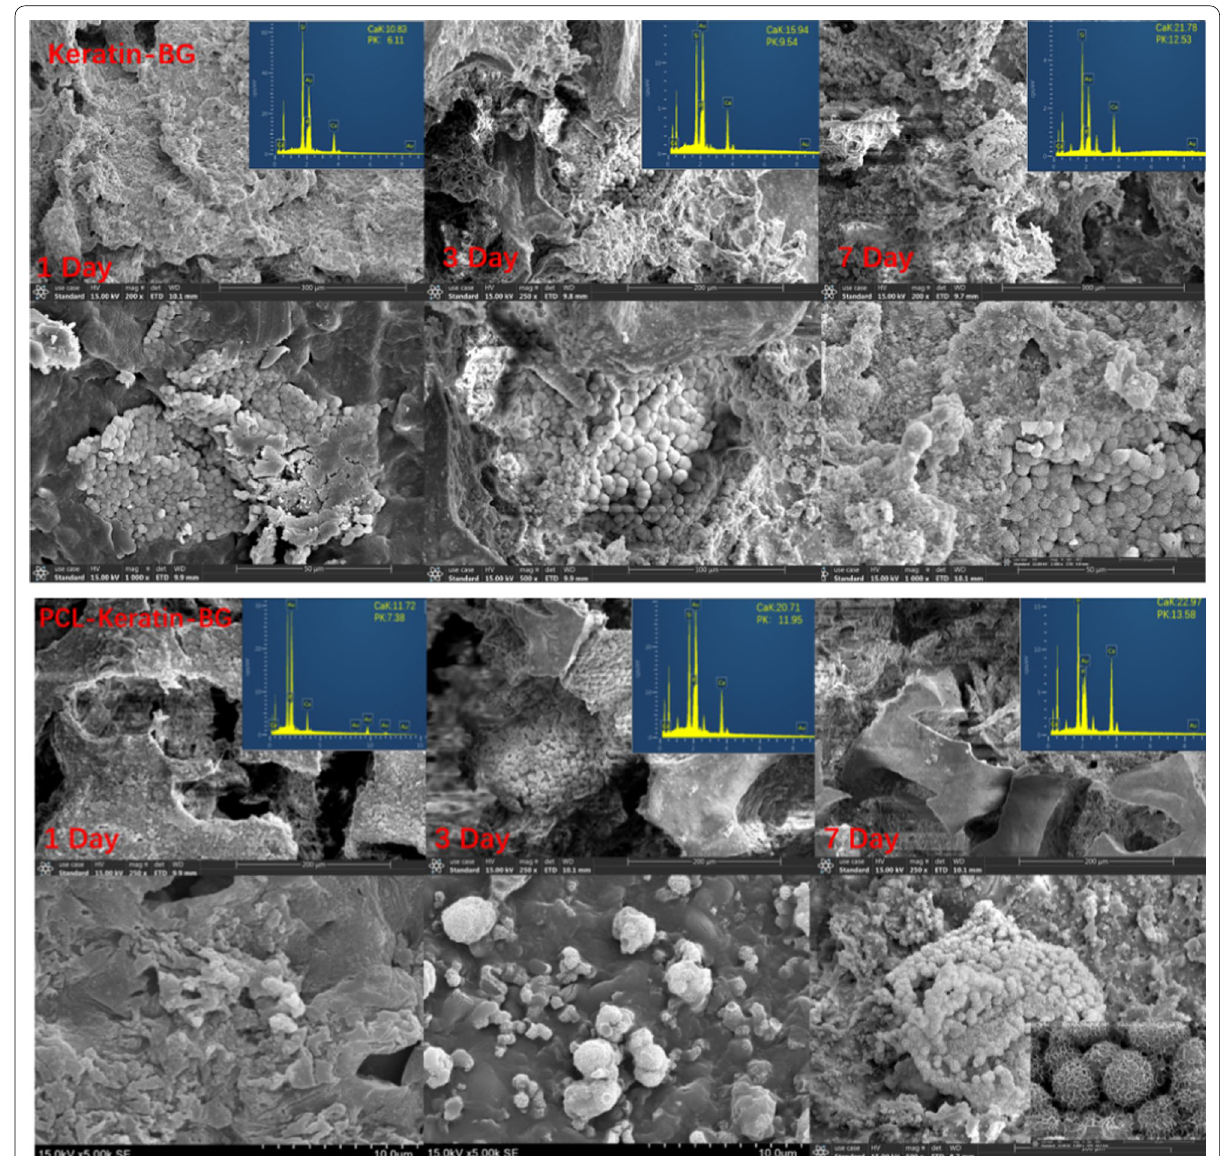
Fig. 7 SEM images of keratin-BG and PCL-keratin-BG scaffolds immersed in simulated body fluid for 1, 3, and 7 days